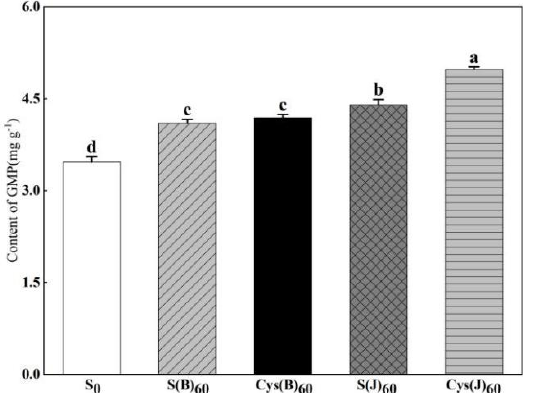
Figure 3. Effects of cysteine and inorganic sulfur at different stages on the contents of GMP in flour. Different small letters in the same column of each treatment are significantly different at a 0.05 probability level.